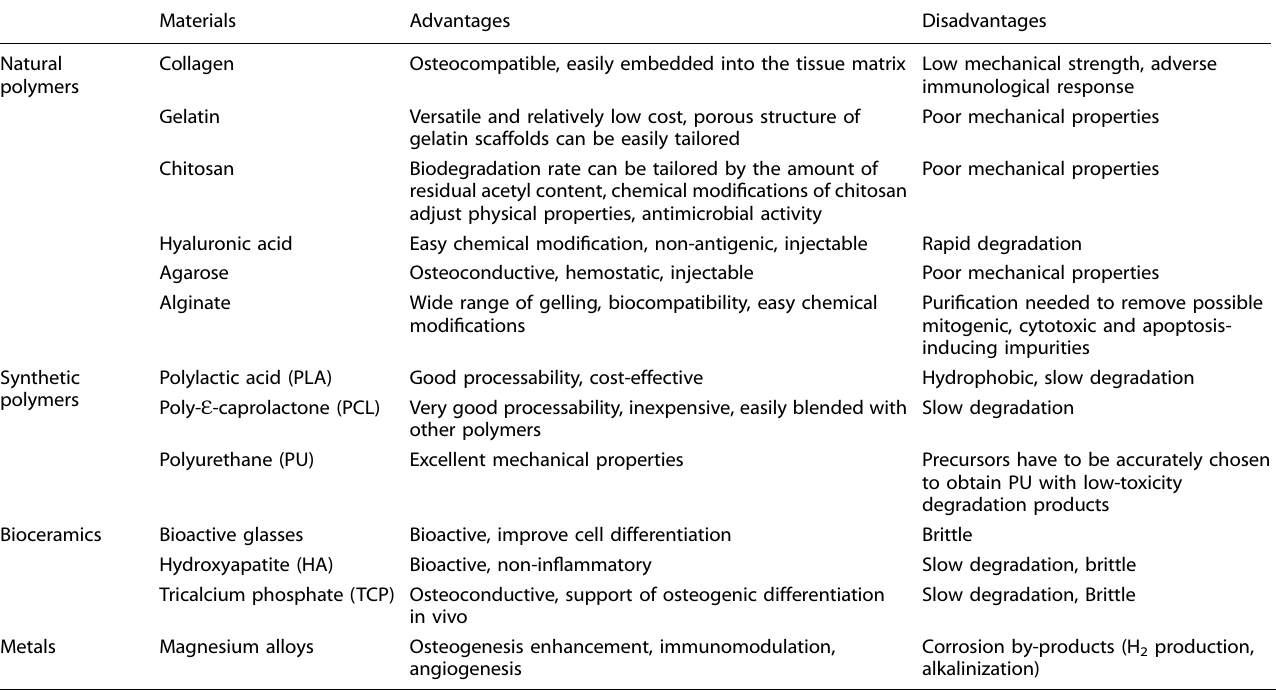
Table 1. Most used materials for bone tissue